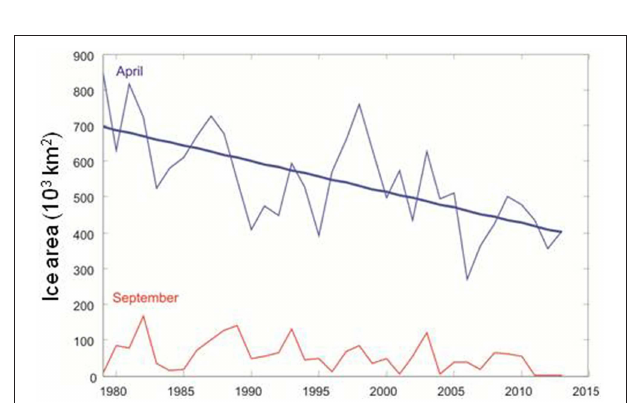
FIGURE 2 | Ice coverage (1000km 2 ) in the Barents Sea in April and September 1980–2013.